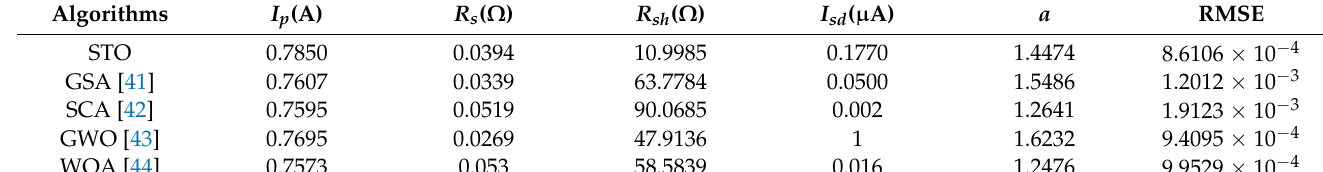
Table 3. Comparison between the STO and other algorithms for parameter estimation techniques for R.T.C France solar cell.